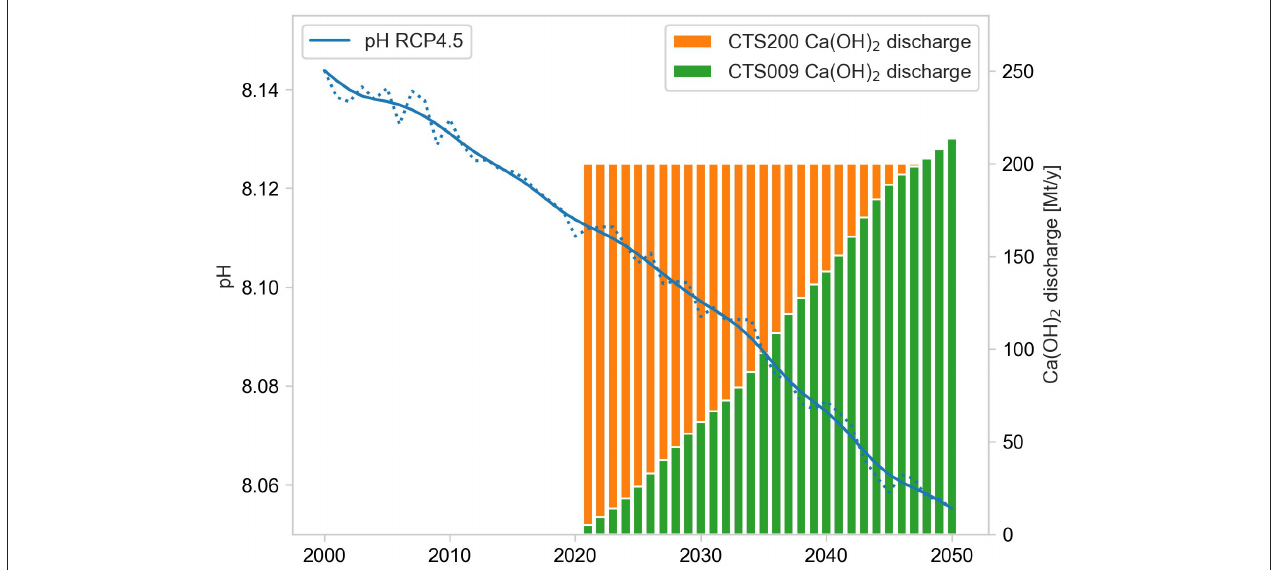
FIGURE 2 | Lime disposal over the Mediterranean basin for the CTS200 (orange) and CTS009 scenario (green) vs. mean surface pH trend of the RCP4.5 baseline scenario (blue; dotted: annual means, full line: smoothed